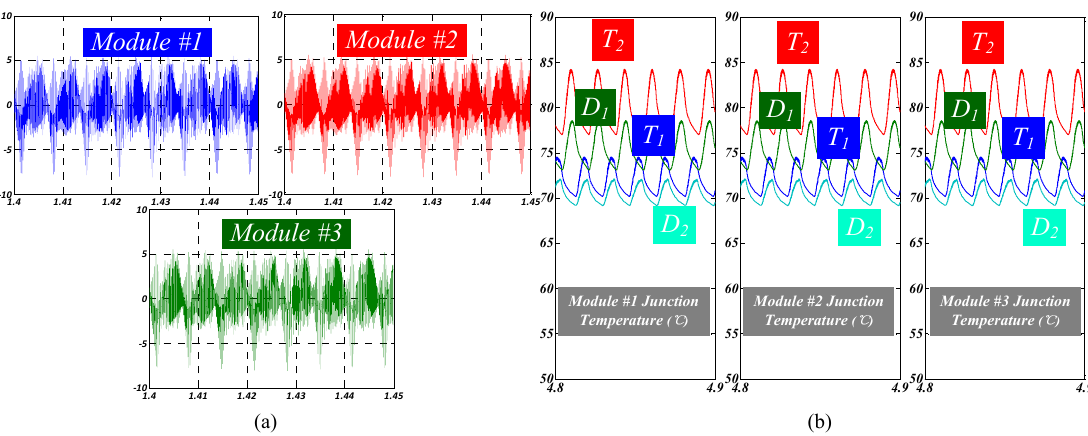
Figure 9. Circulating current and detailed temperature result without circulating current: ( a ) three modules circulating current; and ( b ) detailed temperature in 100% load.